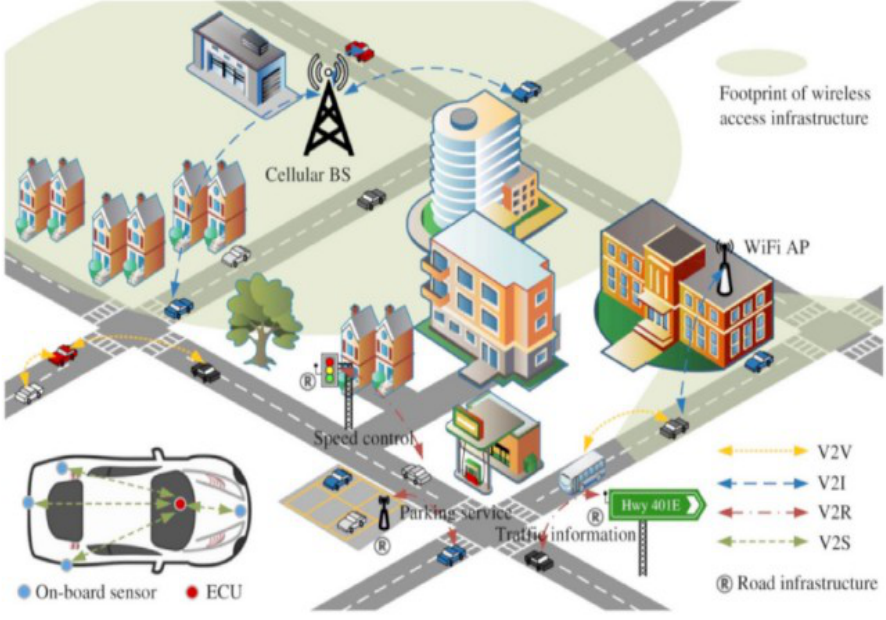
Figure 1. VANET’s